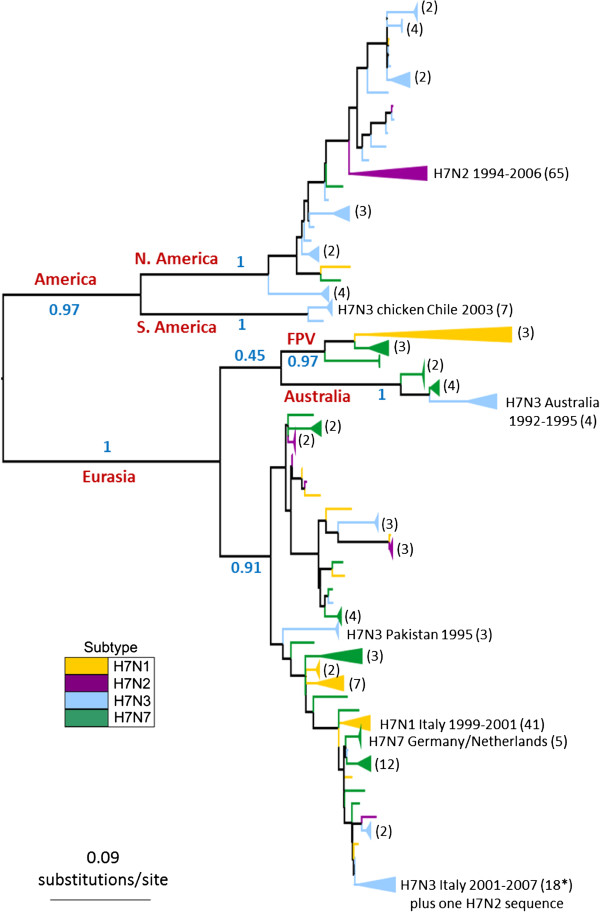
H7 HA1 phylogeny. The tree was inferred using the PhyML software under the GTR + Γ model of DNA substitution, with 6 rate categories. 1000 bootstrap replicates were performed. Major geographical lineages are labelled in red and bootstrap support values (proportion of bootstrap replicates) for major clades are labelled in blue. An H15 sequence was used as an outgroup, but was removed in this figure for the purpose of presentation. Lineages are coloured by the background NA subtype of the virus at the tips of the tree, and clades of sequences of the same subtype have been collapsed for the purpose of presentation (numbers of sequences in collapsed clades are given in brackets). Note: FPV = 'fowl plague virus’, a term used to describe H7 avian influenza viruses isolated in the 1920s-1940s.